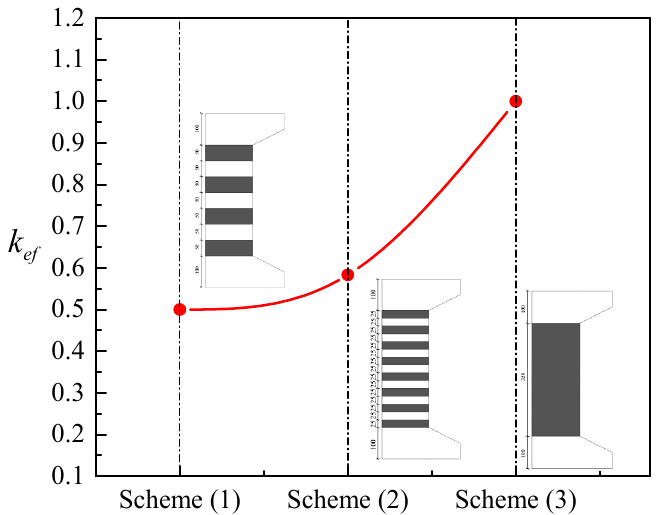
Figure 3. Relationship between different wrapping schemes by Yang et al. [22] and the proposed k ef